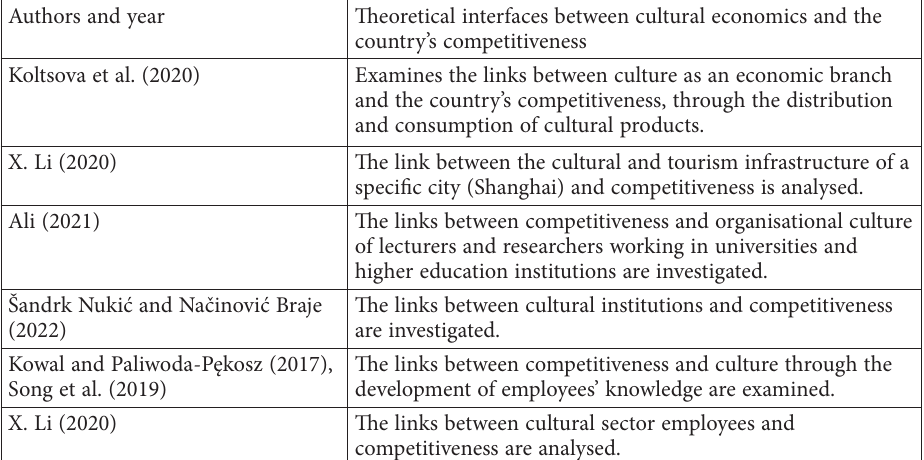
Table 1. Theoretical interfaces between cultural economics and the country’s competitiveness (source: compiled by the